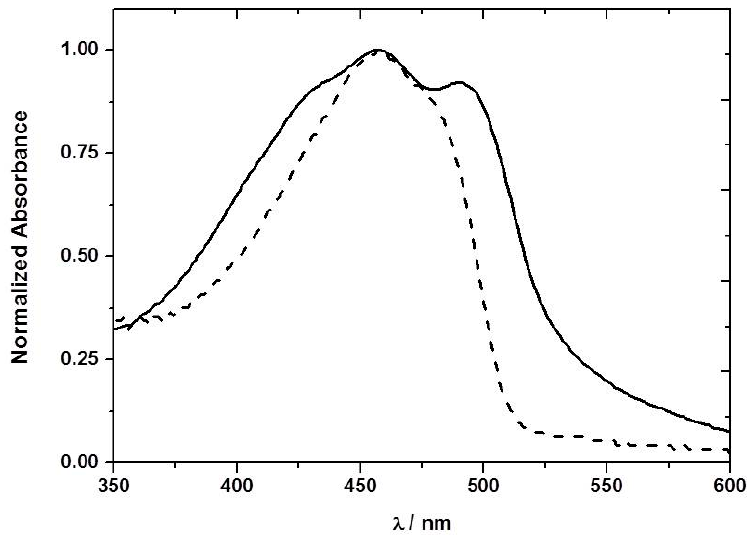
Figure 3. Absorption spectrum of the F8T2 ethyl cellulose film (solid line) and in toluene solution (dashed line).